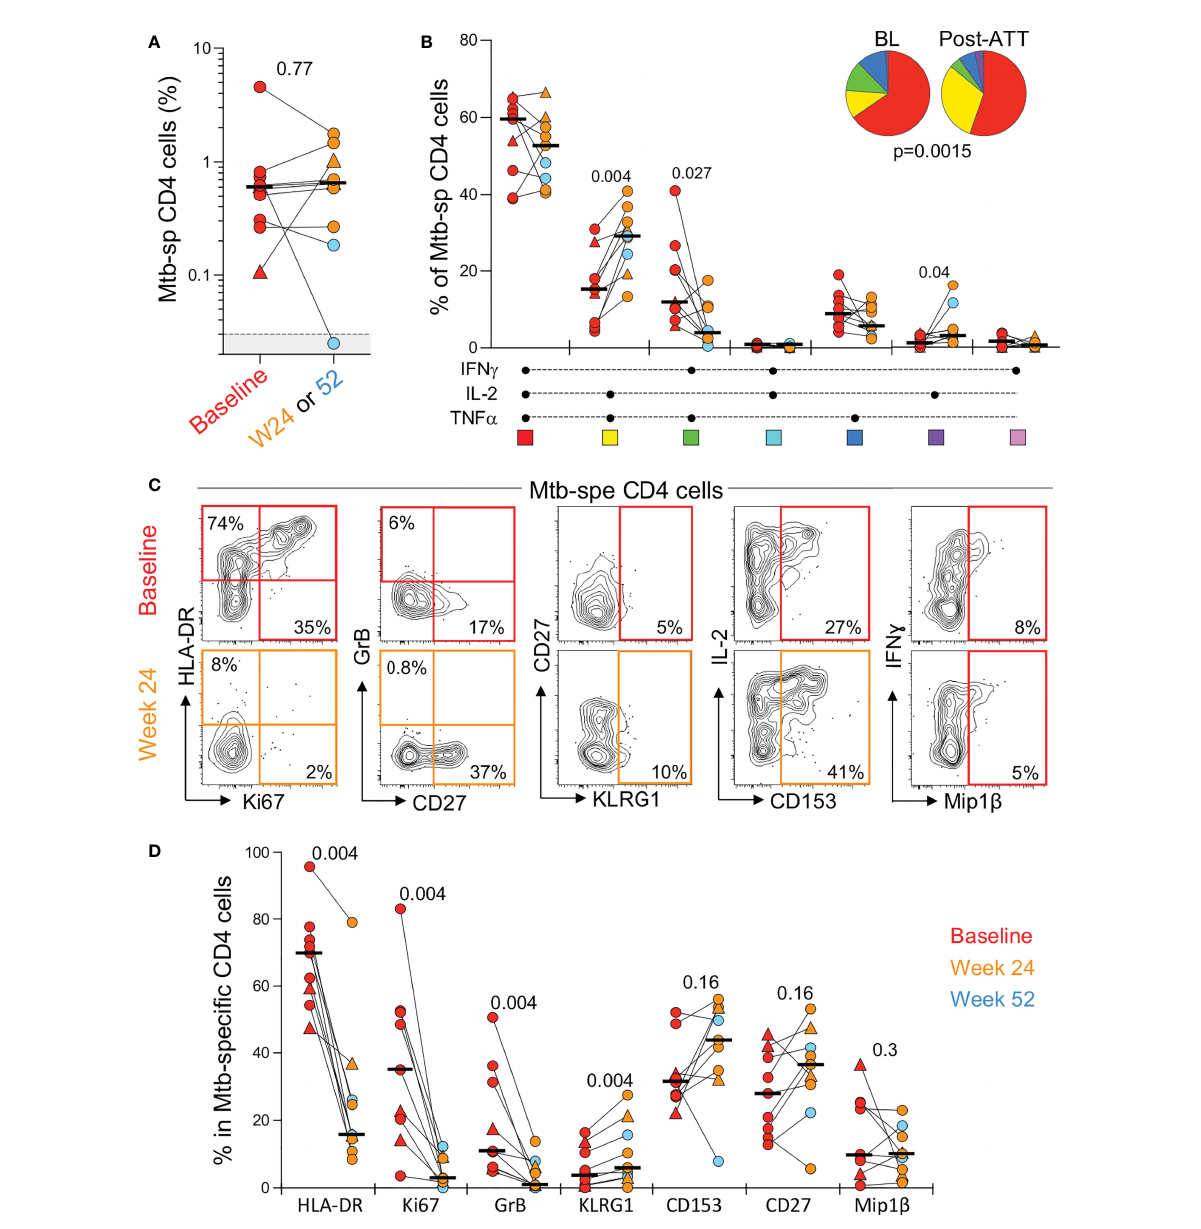
FIGURE 5 Evolution of the magnitude, polyfunctional capacity and phenotypic pro fi le of Mtb-speci fi c CD4 T cells response in whole blood from baseline (pre- ATT initiation) to ATT completion (24 or 52 weeks post-ATT). (A) Frequency of Mtb-speci fi c CD4 T cells pre-ATT (Baseline, red) and post ATT (24 weeks, orange or 54 weeks, light blue) (n = 10 with available samples pre- and post-ATT). The triangles depict HIV-uninfected participants (n = 2). Bars represent medians. Statistical comparisons were performed using the Mann-Whitney test. (B) Polyfunctional pro fi le of Mtb-speci fi c CD4 T cells pre-ATT (BL) and post ATT (W24 or W52). Only paired samples, with a detectable response at both time points, are depicted (n=9). The median and interquartile ranges are shown. A Wilcoxon rank test was used to compare cytokine combination between groups and a permutation test to compare pies. (C) Representative fl ow plots of HLA-DR, Ki67, GrB, CD27, KLRG1, CD153 and MIP1 b expression in Mtb-speci fi c CD4 T cells pre- and post-ATT in one patient. (D) Summary graph of the expression of phenotypic markers measured. Only paired samples are depicted (n=9). Red symbols correspond to Baseline samples, orange to W24 samples and blue to W52 samples. The triangles depict HIV-uninfected participants (n = 2). Bars represent medians. Statistical comparisons were performed using the Wilcoxon rank